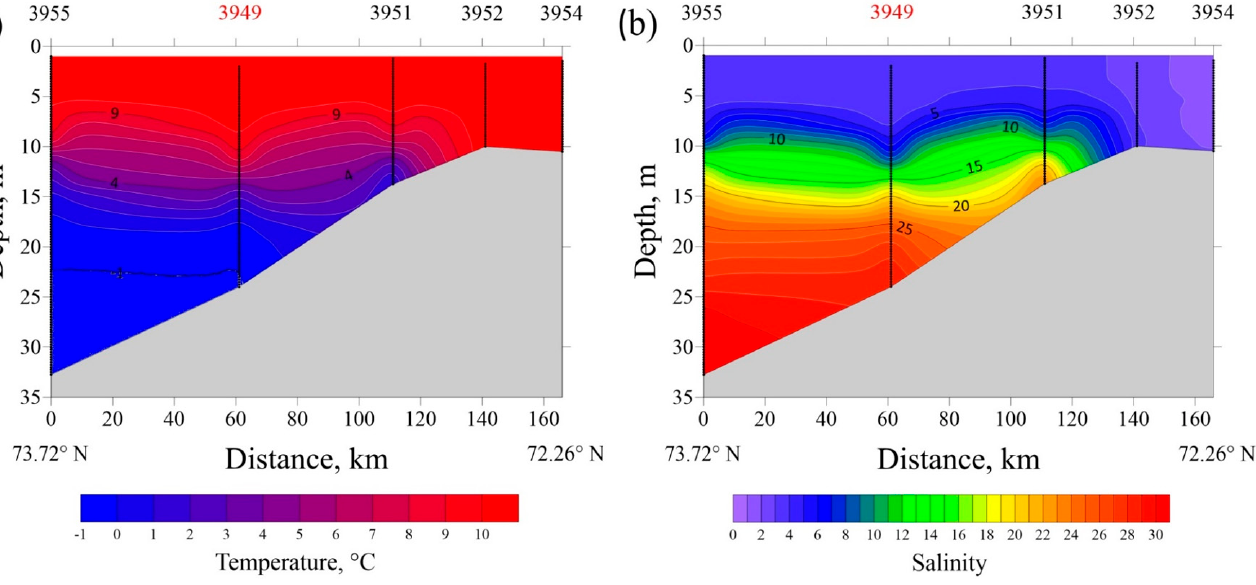
Figure 14. The vertical temperature ( a ) and salinity ( b ) structure along the transect in the Yenisei Gulf (17–19 August 2021). Water samples analyzed in this study were collected at station no. 3949 (indicated by red).